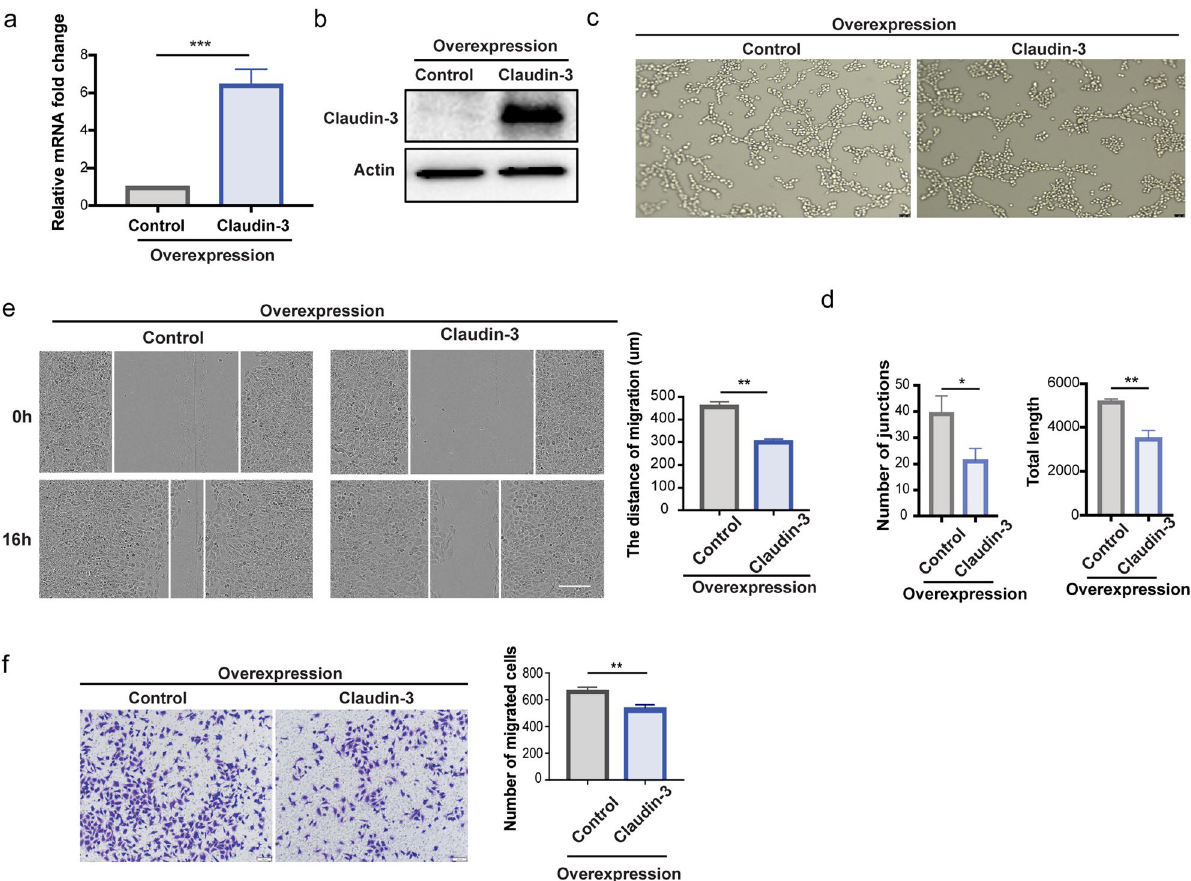
Figure 4. Overexpression of claudin-3 in SVEC4-10 cells inhibits cell migration. ( a ) SVEC4-10 cells were transfected with claudin-3 plasmid to overexpress the protein accompanied with the transfection of control plasmid. RT-PCR analysis was used to examine the mRNA expression in the overexpression and control cells. (*** p < 0.001) (n = 3 per group) ( b ) Western blot analysis indicated the overexpression of claudin-3 protein in SVEC4-10 cell. ( c ) Representative images of tube formation of SVEC4-10 cells transfected with control and claudin-3 overexpression plasmids. Scale bar, 100 μm. ( d ) Number of junctions and total length were analyzed as indicators of tube formation ability via the ImageJ. (* p < 0.05, ** p < 0.01) (n = 3 per group) ( e ) Scratching assay was conducted and the photos were taken under a microscope. Scale bar, 100 μm. Wound width was quantified and analyzed by t-test. (** p < 0.01) (n = 5 per group) ( f ) Transwell assay was conducted and the representative images were taken. Scale bar, 100 μm. Cells on the bottom side were counted and analyzed by t-test. (** p < 0.01) (n = 5 per